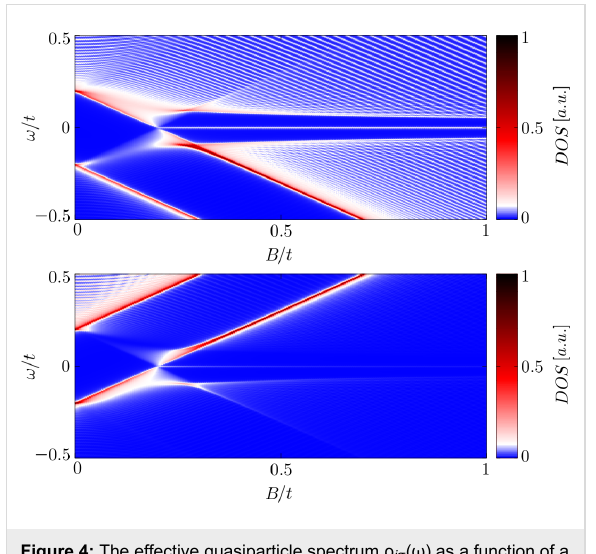
Figure 4: The effective quasiparticle spectrum ρ i σ ( ω ) as a function of a magnetic field B aligned along the nanochain obtained for σ = ↑ (upper panel) and σ = ↓ (bottom panel). The magnetic field B is expressed in units of t /( g μ B /2).